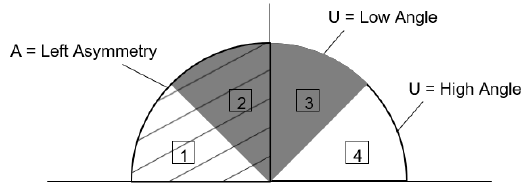
Figure 8. Schematic showing the wave angle direction, defined by the wave climate asymmetry ( A ) and the proportion of high-angle to low-angle waves ( U ) with the numbers denoting the four